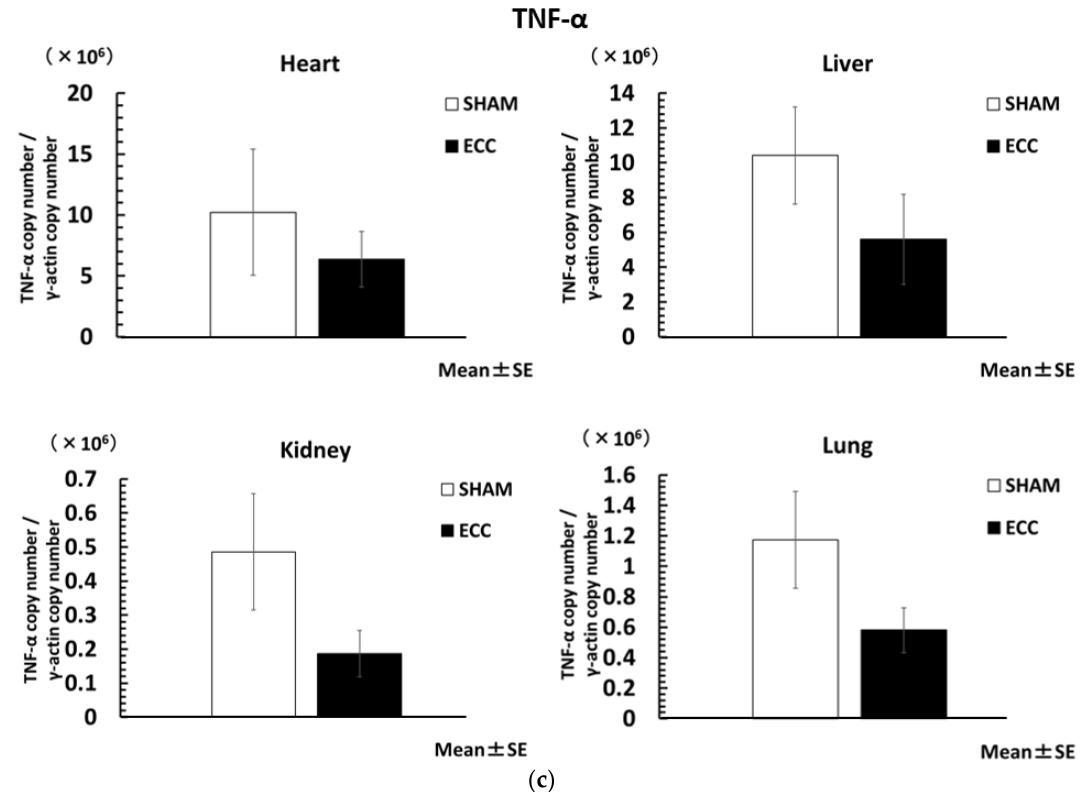
Figure 3. Monocyte chemoattractant protein (MCP)-1 ( a ), interleukin (IL)-6 ( b ), and tumor necrosis factor (TNF)-α ( c ); * p < 0.05 versus SHAM group.